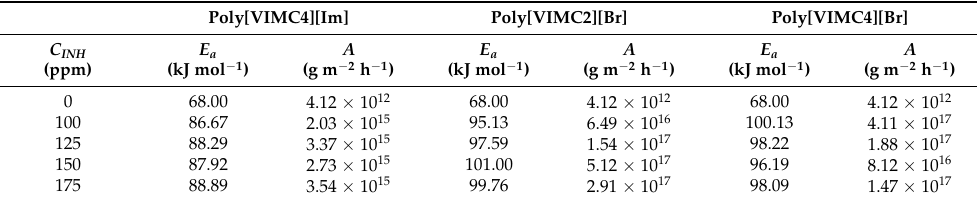
Table 6. Kinetic parameters of the inhibition process of API 5L X60 steel in 1 M H 2 SO 4 with and without